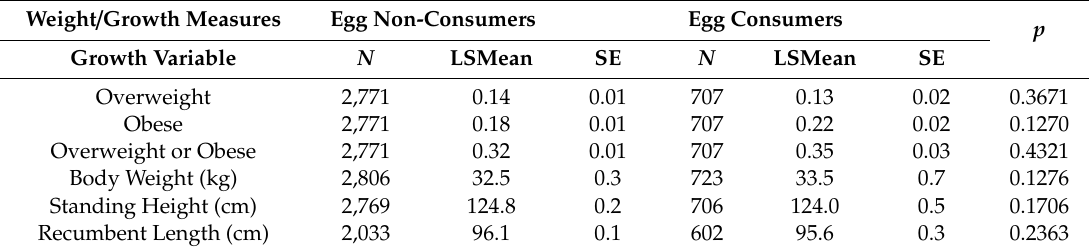
Table 5. Adjusted mean (SE) weight and growth measures for egg consumers vs. egg non-consumers. Weight / Growth Measures Egg Non-Consumers Egg Consumers p Growth Variable